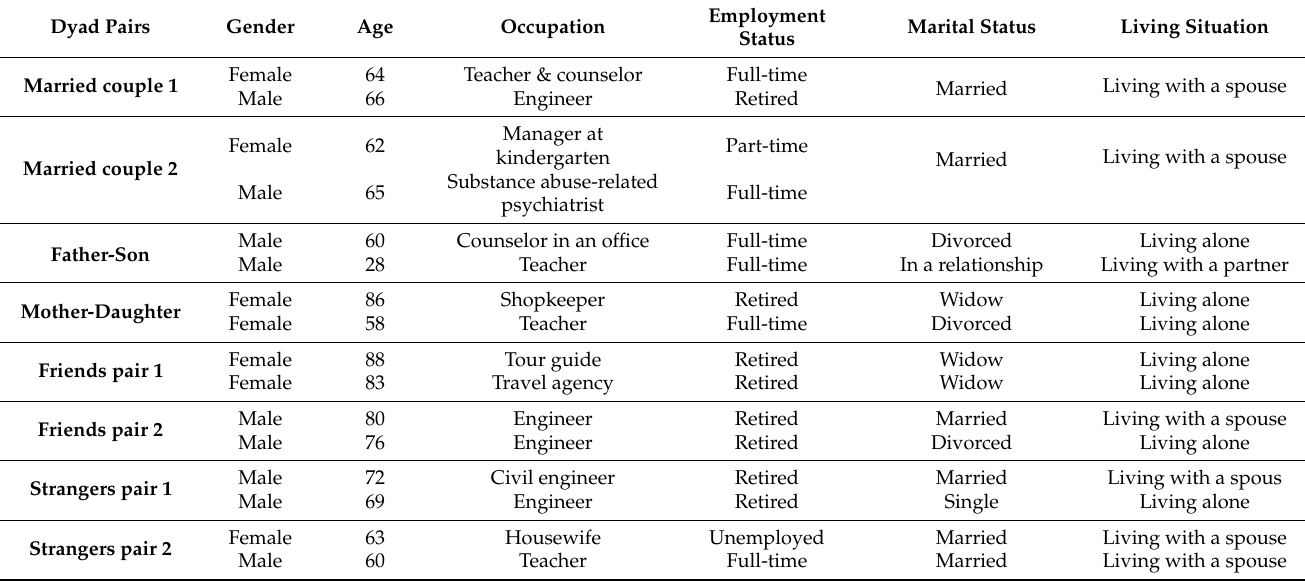
Table 1. Description of participant characteristics from dyadic